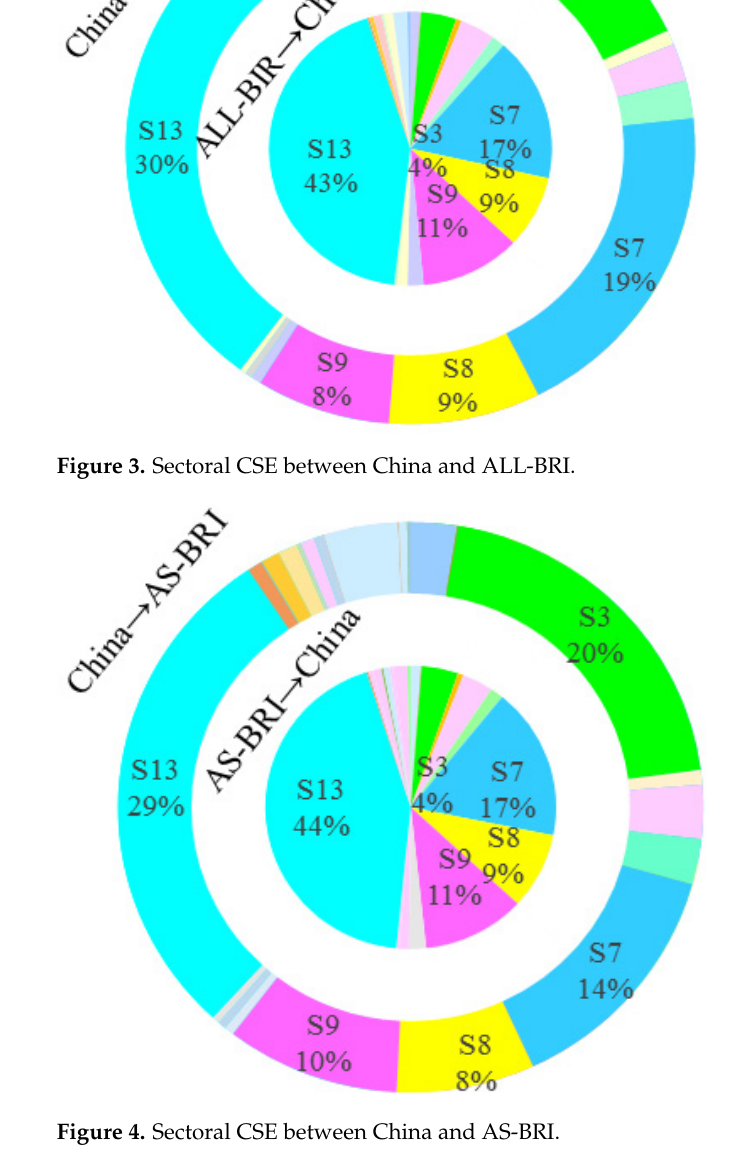
Figure 4. Sectoral CSE between China and AS-BRI.